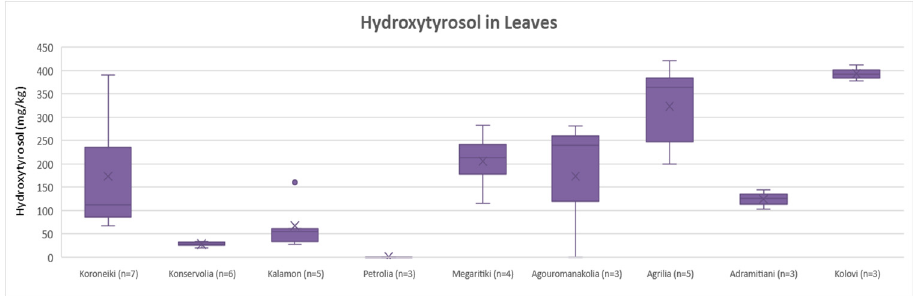
Figure 5. Box and whisker plot for the concentrations of hydroxytyrosol among di ff erent varieties of